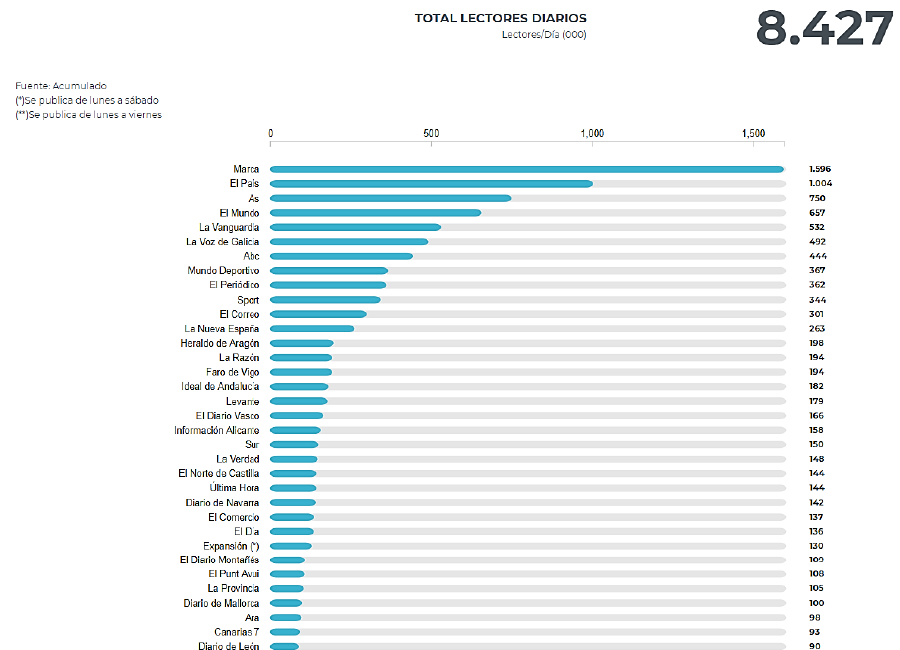
Figure 1. Ranking of the most read newspapers in Spain according to the Estudio General de Medios (EGM) carried out by the Asociación para la Investigación de los Medios de Comunicación (AIMC). Source: EGM 2020. Source: https://reporting.aimc.es/index.html#/main/diarios.